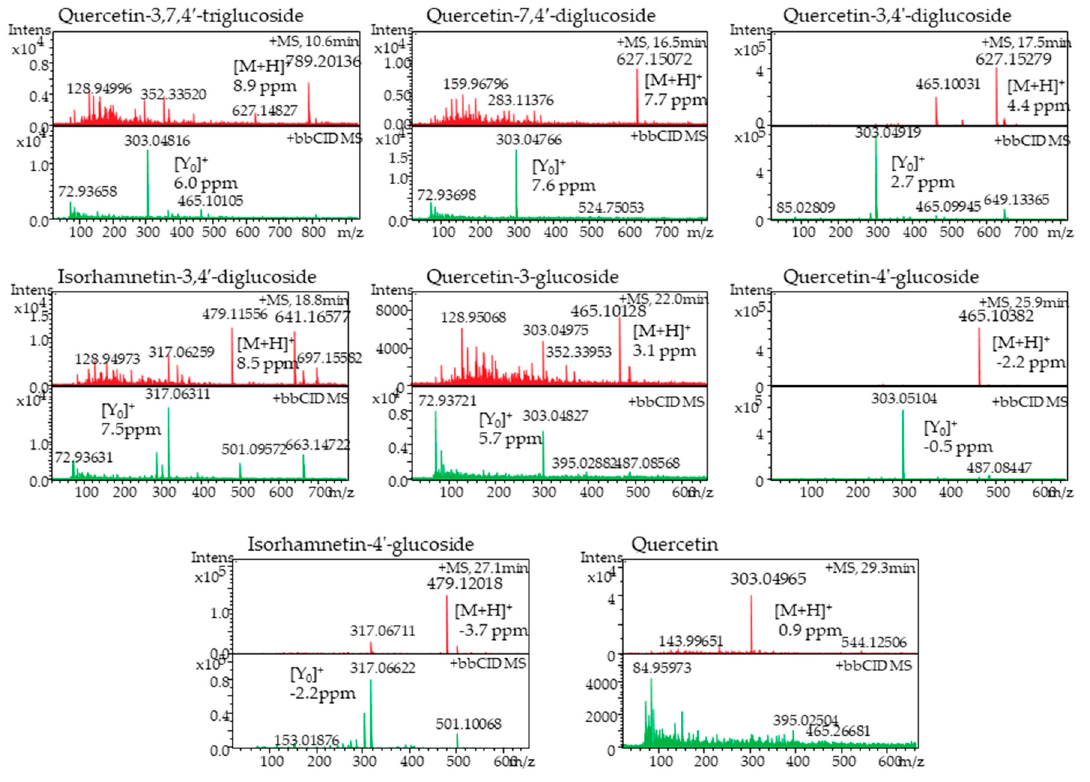
Figure 5. Red onion flavonoids mass spectra identified in positive-ionization mode by LC-HR-ESI- QTOF-MS.